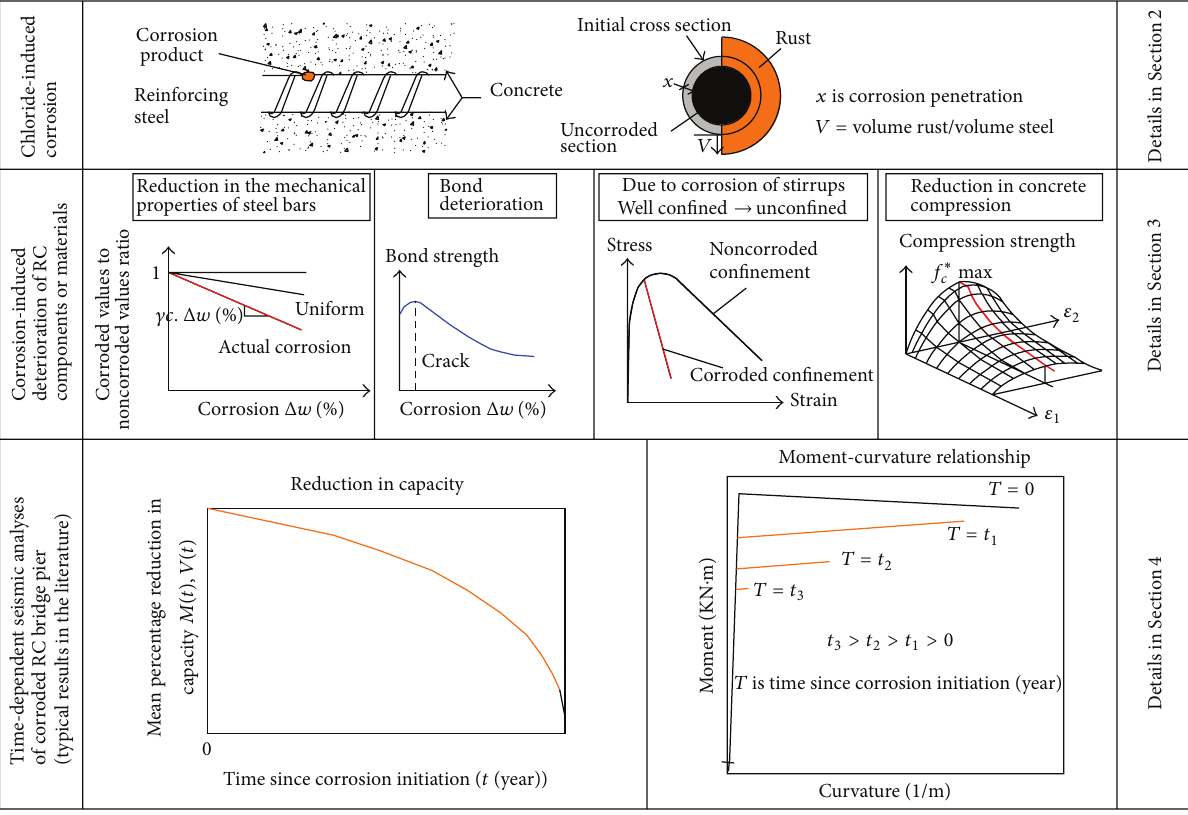
Figure 2: Overview of main parts of long-term seismic performance of corroded RC bridge